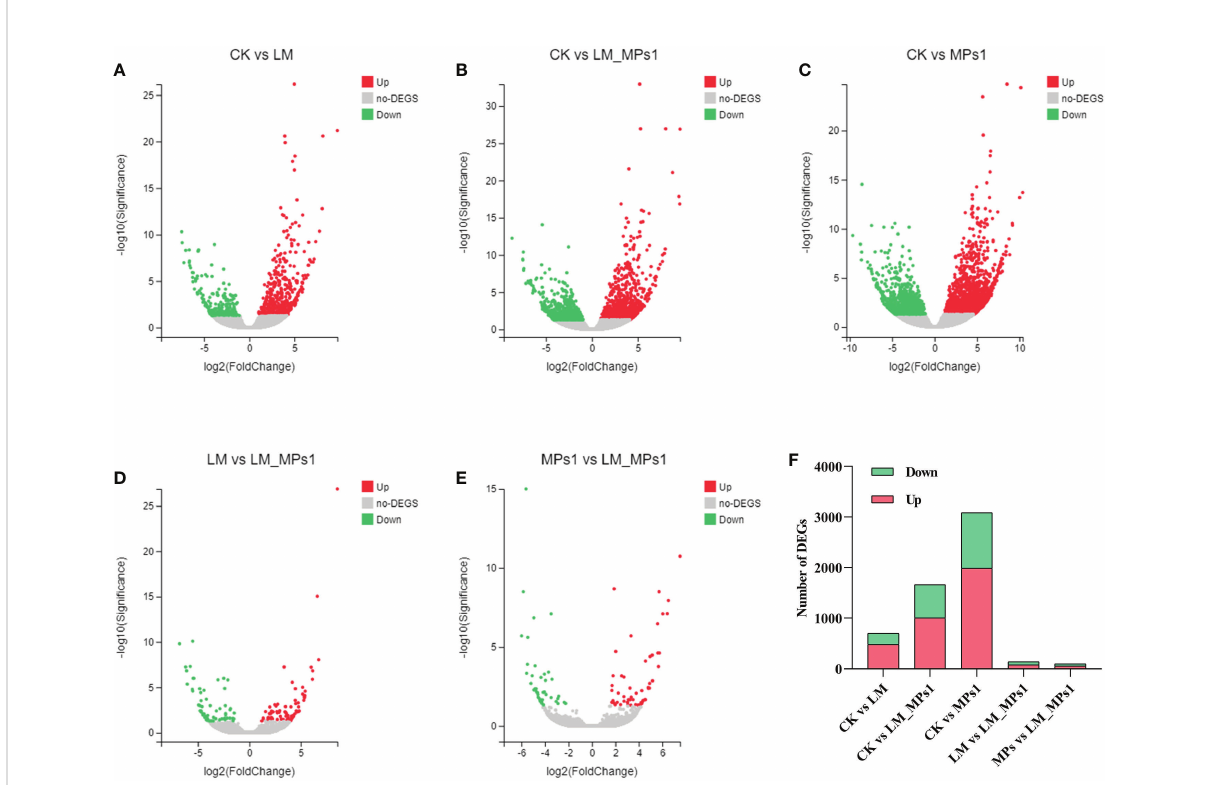
FIGURE 3 The volcano maps of DEGs in different pairwise comparisons of the digestive gland (A-E) . Number of DEGs from pairwise comparisons among the fi ve groups of the digestive gland (F) . CK, control; LM, P. lima exposure; LM_MPs1, P. lima & 0.2 mg/L MPs exposure; MPs1: 0.2 mg/L MPs